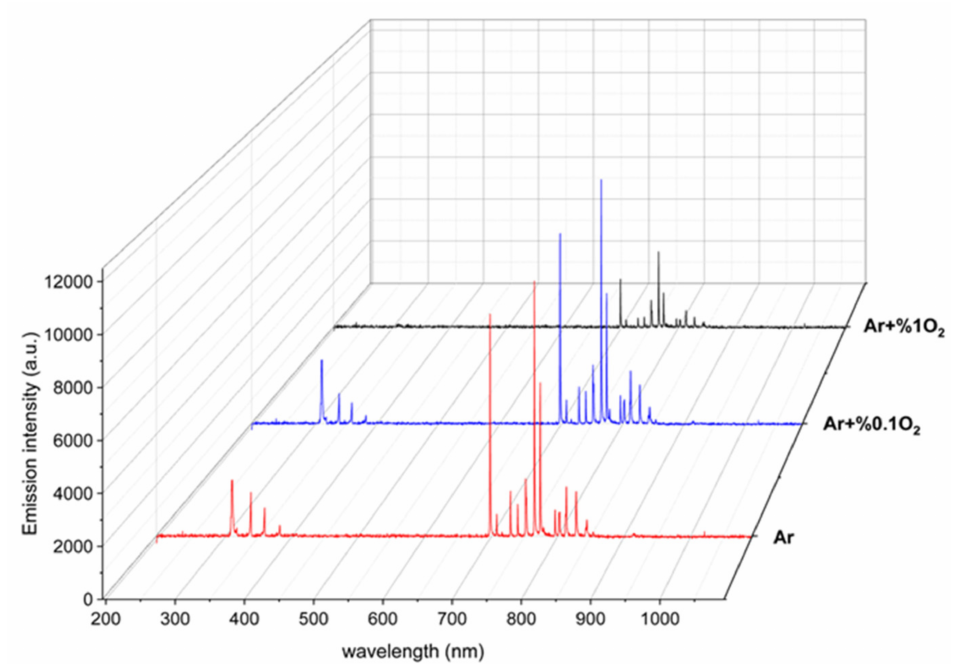
Figure 4. The optical emission spectroscopy of the LTP jet array with the working gas of argon, argon + 0.1% O 2 , argon + 1% O 2